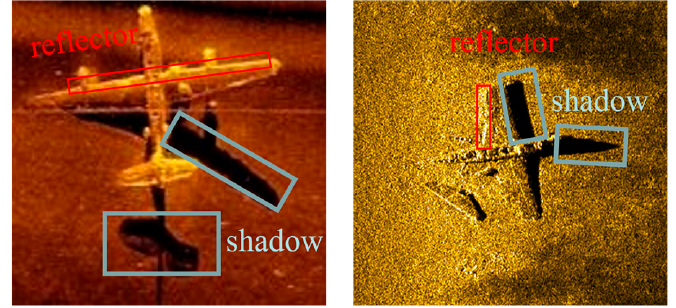
6 of 18 Figure 6. Original sonar image with optical target transfer to sonar style target. ( a ) Original sonar image. ( b ) Optical image. ( c ) Traditional style transfer image. ( d ) Feature enhancement style trans ‐ fer image. Generally, style transfer can be described as being in two steps. First, the style transfer